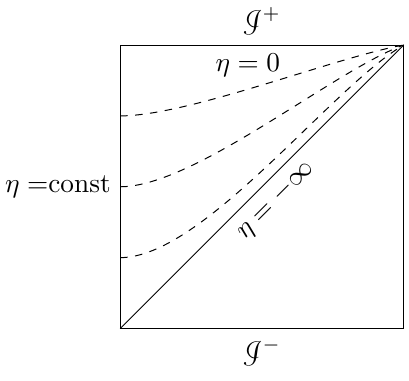
Figure 2 . Conformal diagram of dS in the Poincaré